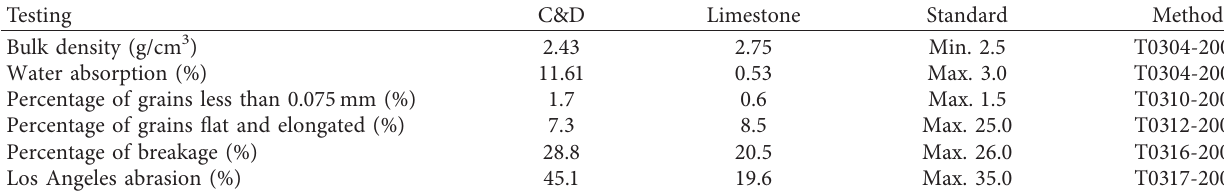
Table 2: Physical properties of coarse aggregate.